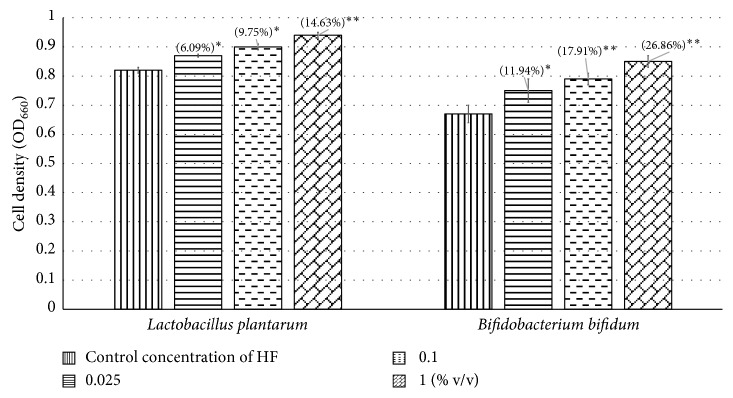
Growth-promoting effect of HF on probiotic strains. ∗
p < 0.05; ∗∗
p < 0.01. Bacterial growth was measured as OD660.